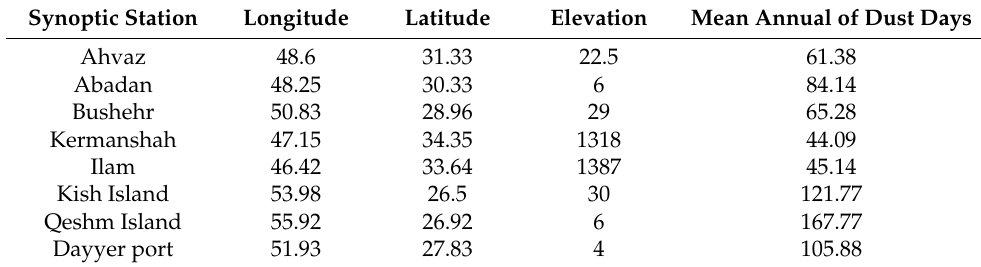
Table 1. The 8 selected synoptic weather stations in the west, southwest, and south of Iran, and the mean annual number of dust days from 1997 to 2017. Synoptic Station Longitude Latitude